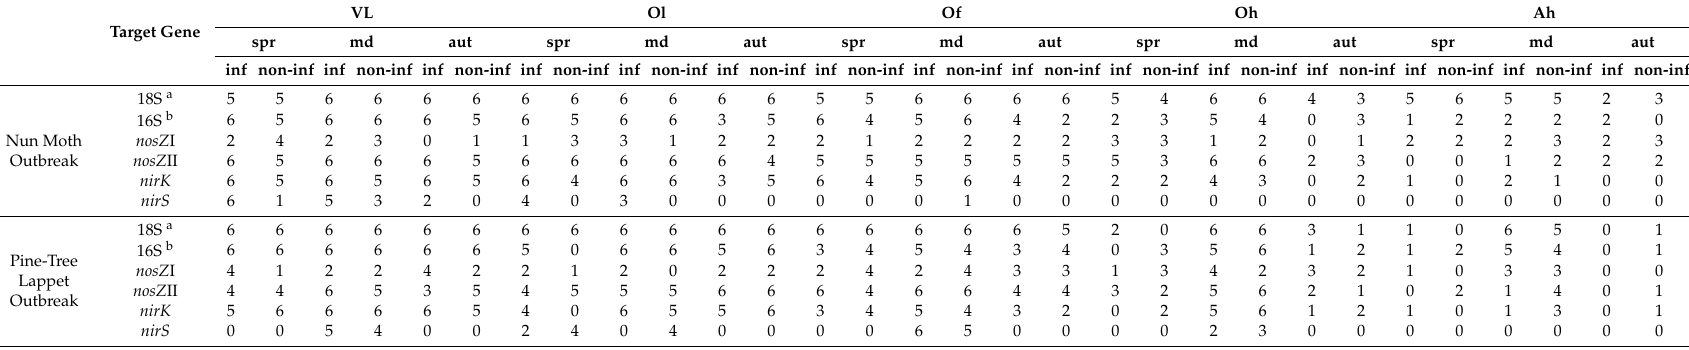
Table A5. Samples above the detection limit for fungal 18S and bacterial 16S rRNA gene abundance, nirK , nirS , nosZ I and nosZ II for the different soil horizons and sampling dates in nun moth ( Lymantria monacha L.) and pine tree lappet ( Dendrolimus pini L.) infested and non-infested Scots pine ( Pinus sylvestris L.) forest sites.